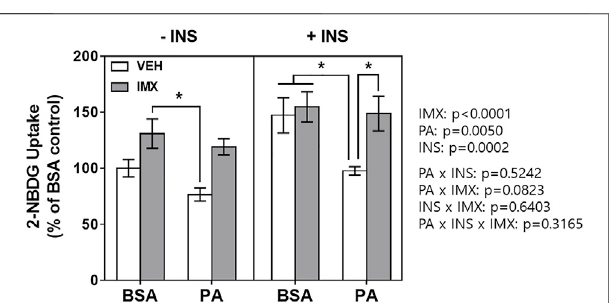
FIGURE 4 | Effect of palmitate and imoxin on glucose uptake in C2C12 myotubes. Glucose uptake monitored by 2-NBDG assay. To stimulate glucose uptake, cells were washed with sterile PBS twice and then treated with or without 50 nM insulin in serum-free DMEM without glucose for 30 min. After 30 min of insulin stimulation, 2-NBDG was added to cells at the fi nal concentration of 100 μ g/ml for another 30 min. Values are presented as mean ± SEM (N = 3). Main effects and interactions were analyzed by three- way ANOVA (IMX x PA x insulin) as described on the right side of the panel: * p < 0.05 by Tukey ’ s post hoc analysis after three-way